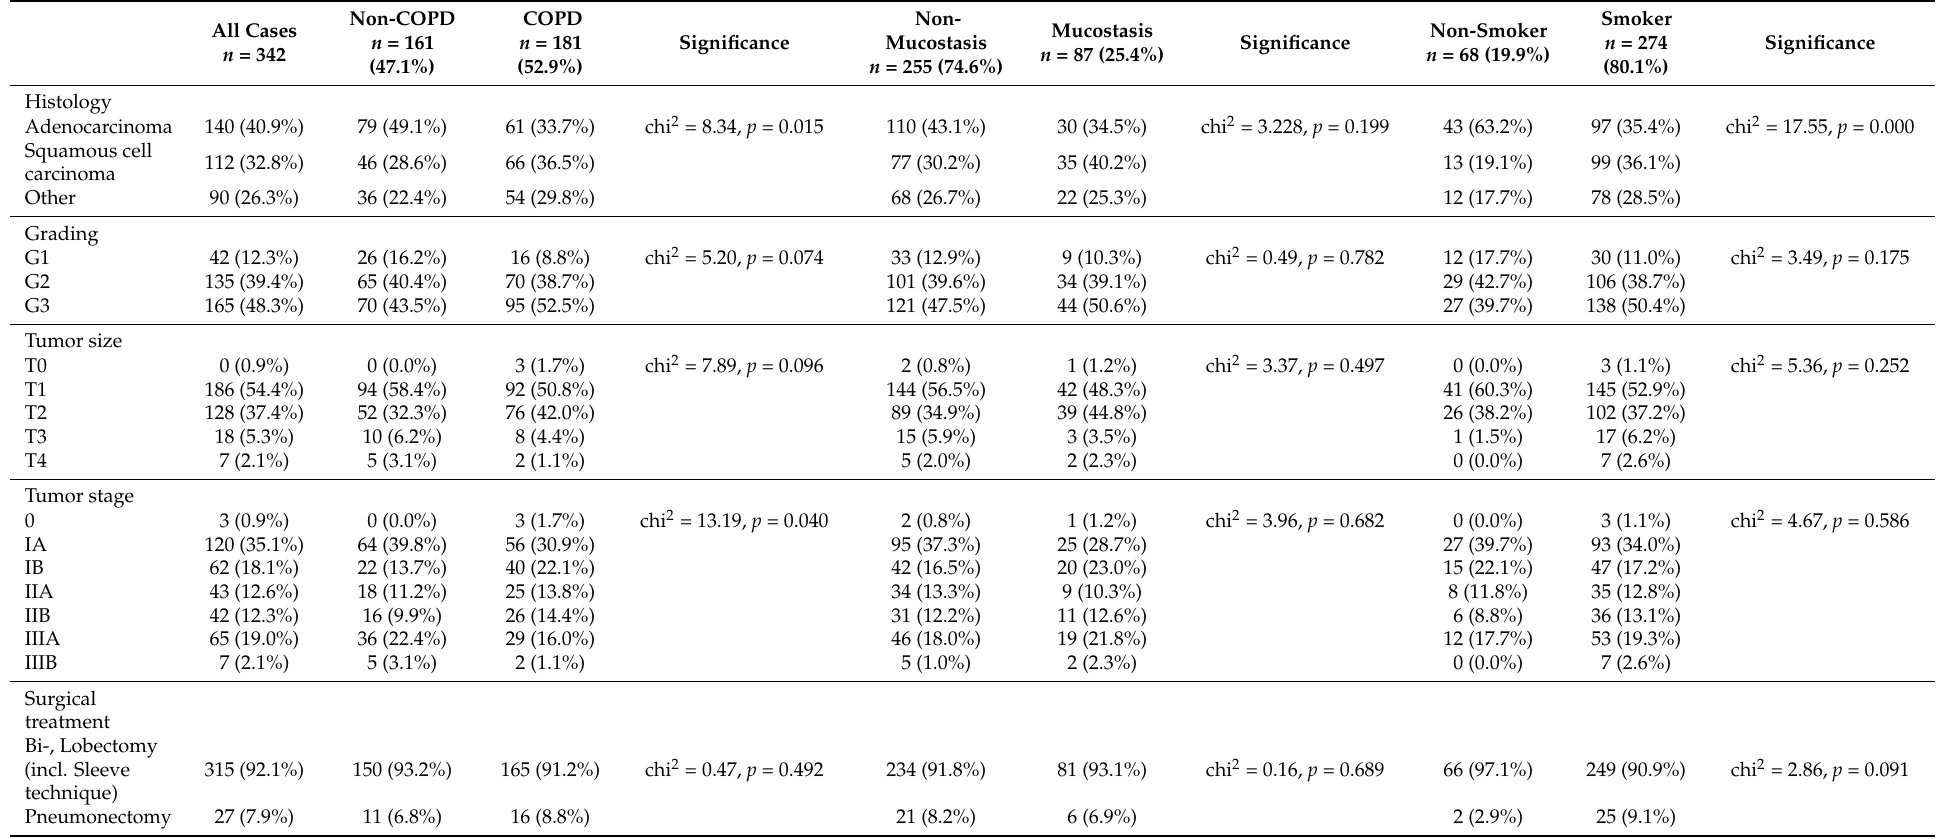
Table 2. Clinico-pathological characteristics of 342 patients undergoing curative resection for NSCLC focusing on tumor-related data. p values refer to chi 2 for categorical variables. Abbreviations: COPD: Chronic obstructive pulmonary disease, G: histological grading, T: T stage (tumor invasion), UICC: International Union against